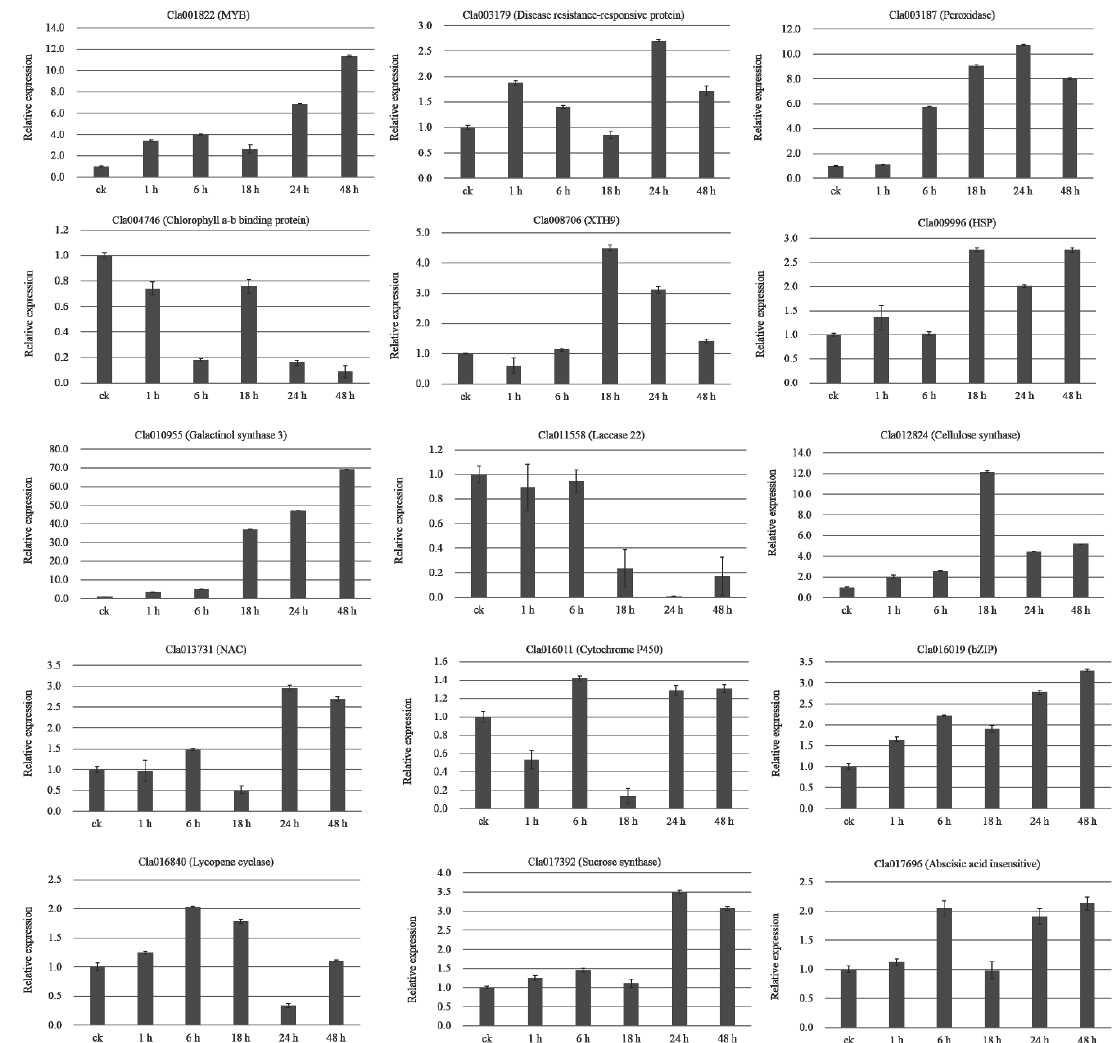
Figure 7. qRT-PCR analysis of the expression of CGMMV response-related genes. The y -axis represents the log2 values (CGMMV/ck). Analyses were completed in triplicate, and the error bars represent the standard errors.